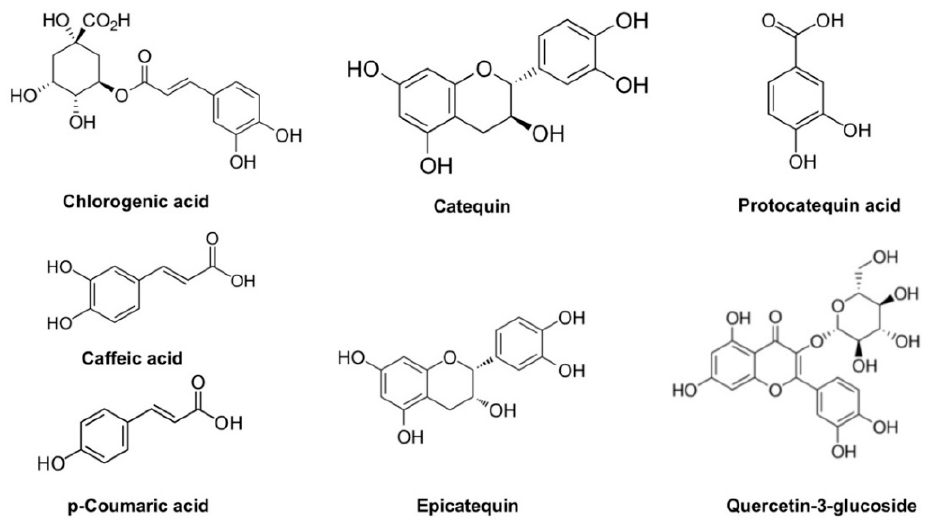
Figure 4. Chemical structures of main polyphenolic compounds reported in AS residues.